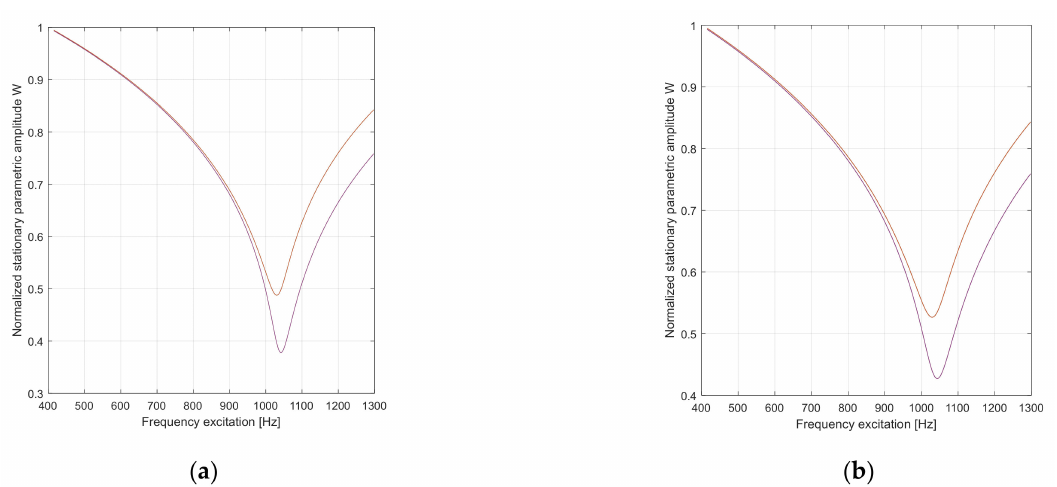
Figure 12. Normalized stationary parametric amplitude W of the tulip for χ nT = 0.25, where µ = 0.623 × 10 − 4 . ( a ) ζ = 0.0216. ( b ) ζ =